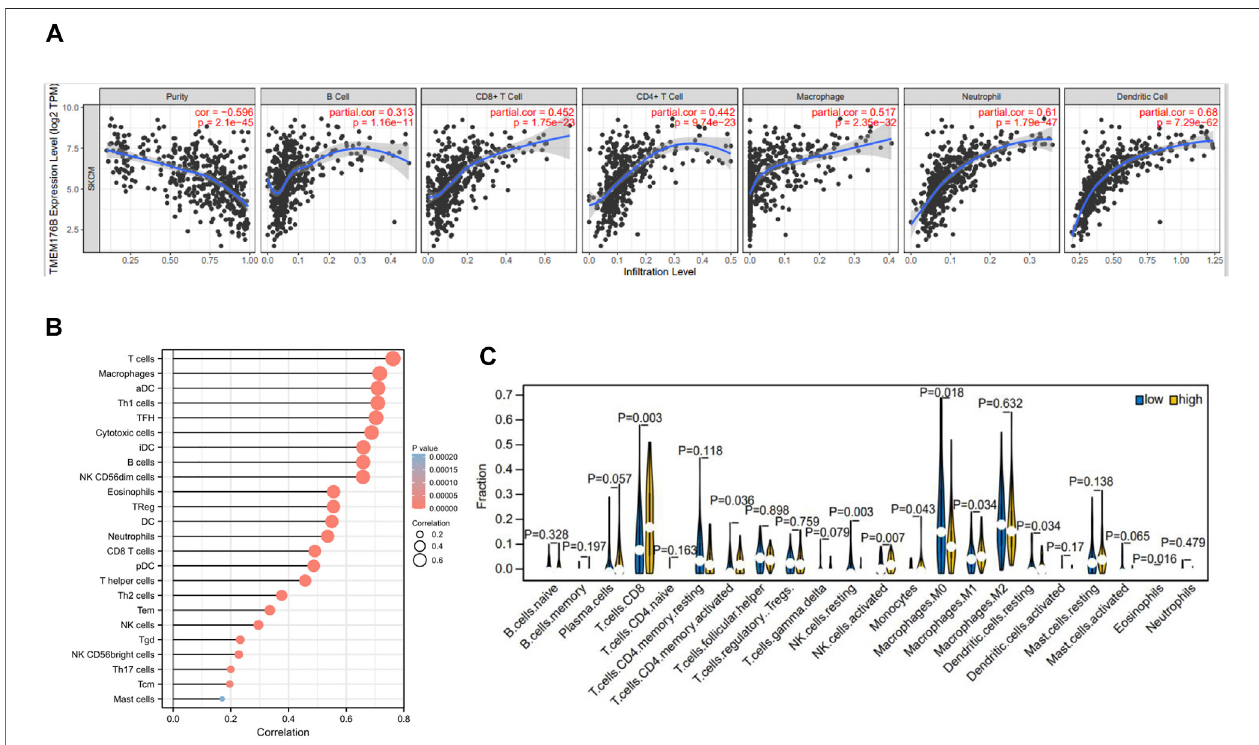
FIGURE 4 | Correlation of TMEM176B expression and the level of immune in fi ltration in SKCM. (A,B) In SKCM, the in fi ltration levels of B cells, CD8 + T cells, CD4 + T cells, macrophages, neutrophils, dendritic cells and other immune cells with TMEM176B expression. p < 0.05 is considered signi fi cant. (C) The varied proportions of 22 subtypes of immune cells in high and low TMEM176B expression groups in tumor